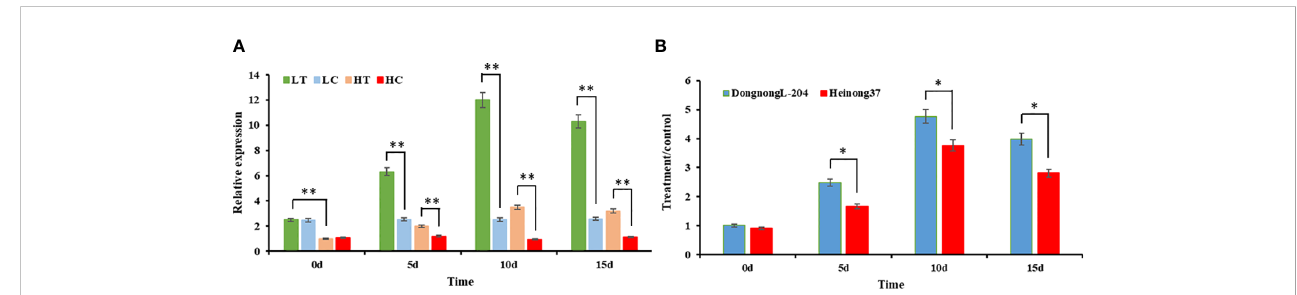
FIGURE 7 Analysis of the expression pattern of GmHg1 . (A) Relative expression of GmHg1 in resistant and susceptible varieties. LT, ‘ Dongnong L-204 ’ treatment; LC, ‘ Dongnong L-204 ’ control; HT, ‘ Heinong 37 ’ treatment; HC, ‘ Heinong 37 ’ control. (B) Increase in GmHg1 expression. Asterisks indicate a signi fi cant difference compared with the corresponding control (Student ’ s t -test: ** p < 0.01). Values represent the means of three biological replicates. *p <